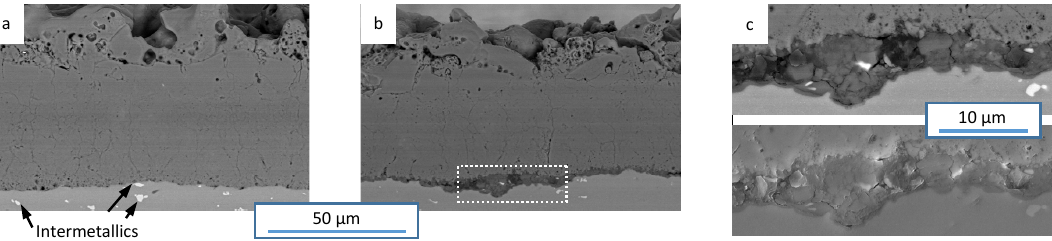
Figure 5. Backscatter SEM images of a sample which was exposed to electrolyte I at cross-sections of the unaffected ( a ) and affected region ( b ), as well as close-ups of the substrate/coating interface in backscatter (top) and secondary (bottom) electron mode ( c ).